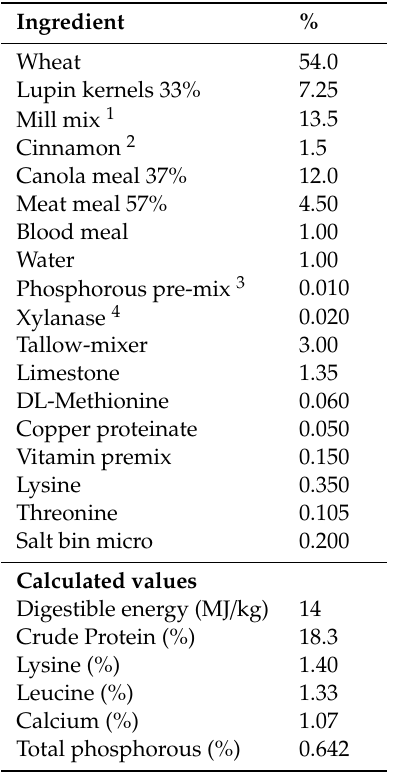
Table 1. Formulation parameters of experimental